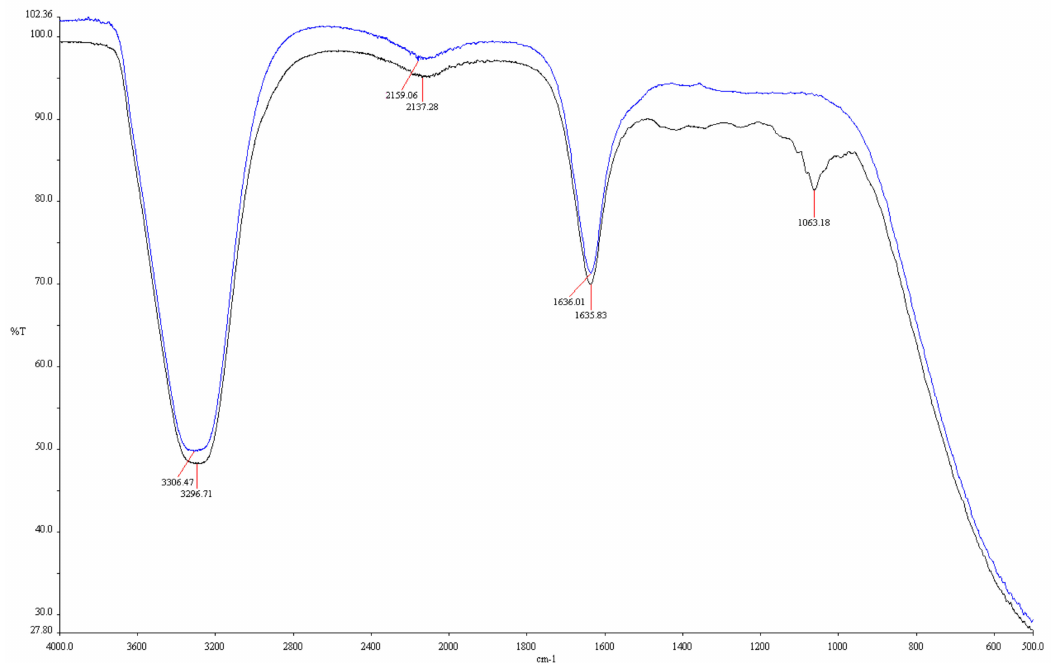
Figure 4. Fourier transform infrared spectroscopy (FT-IR) spectra of Lycopersicon esculentum extract (blue line) and biosynthesized AgNPs (black